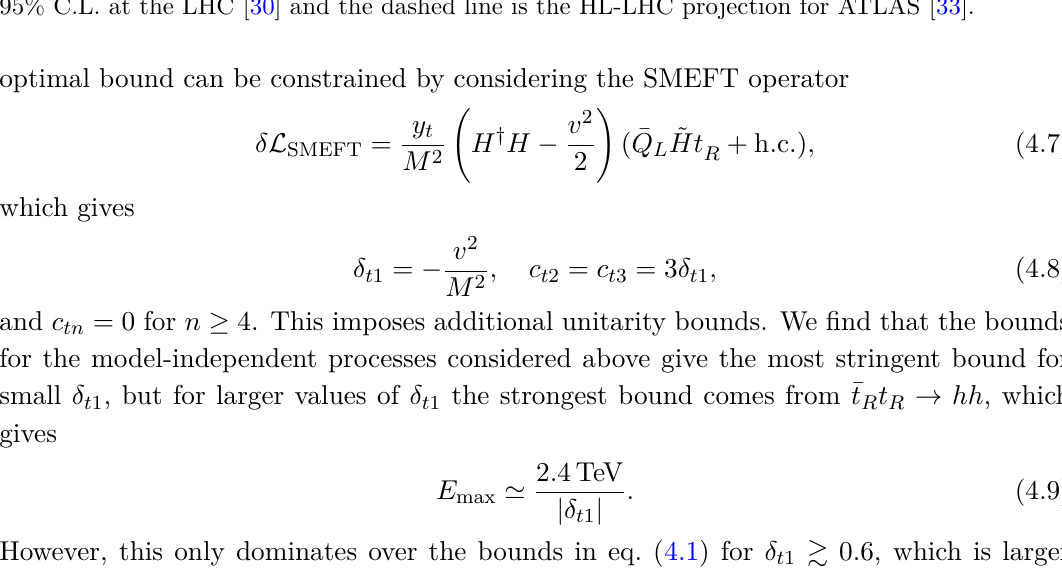
Figure 9 . Unitarity violating scales given values of δ t 1 and δ V 1 . The solid line represents the 95% C.L. at the LHC [30] and the dashed line is the HL-LHC projection for ATLAS